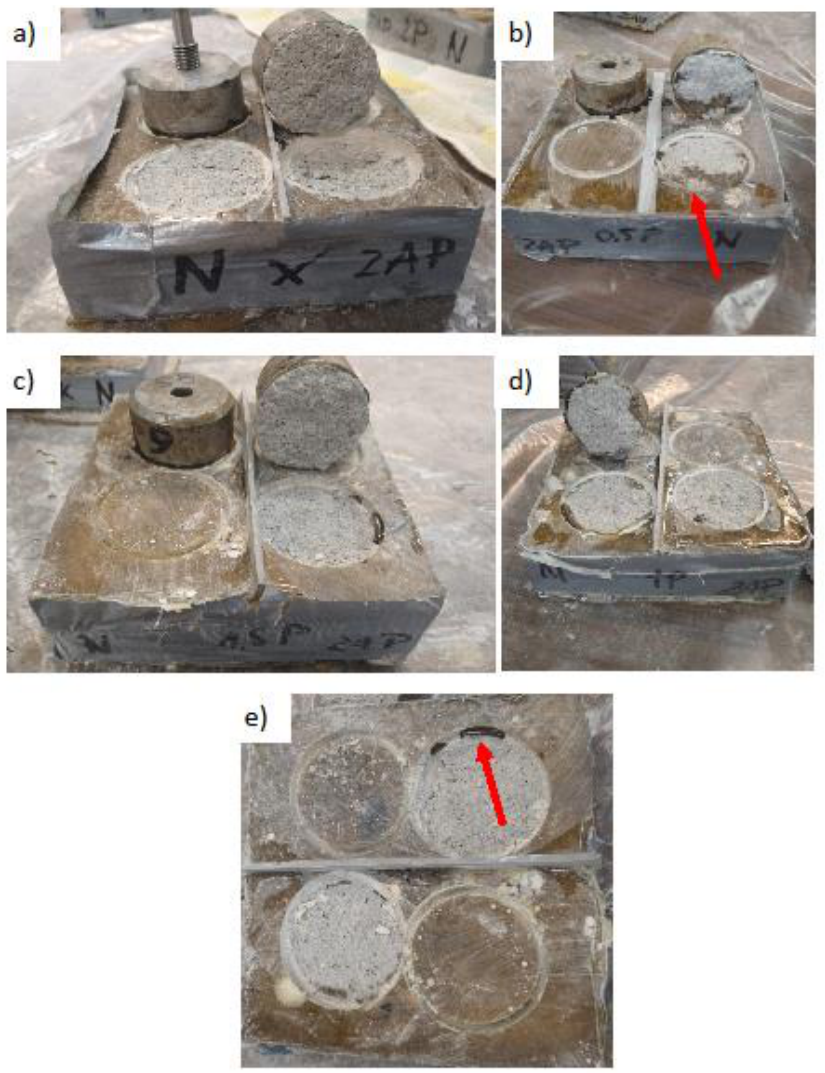
Figure 14. Photos of the mortar samples after detaching: ( a ) without additive (cohesive failure), ( b ) 0.5 wt % (adhesive failure), ( c ) 1 wt % (cohesive failure), ( d ) 1.5 wt % (cohesive failure), ( e ) 2 wt % (cohesive failure).